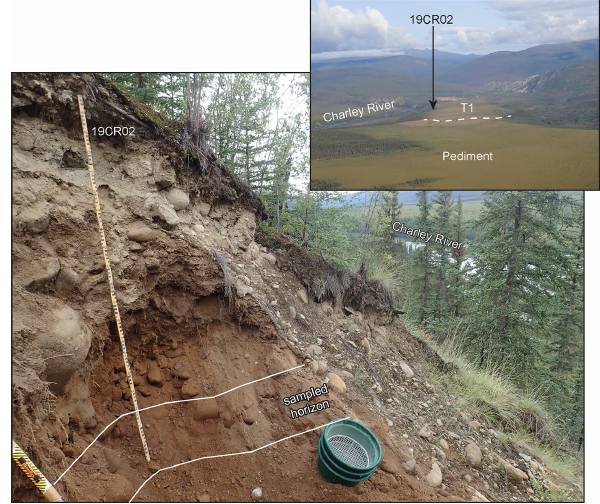
Figure A1. Cosmogenic isochron burial age sample site 19CR2. Site located on the Charley River high terrace (T1) in Alaska near the headwaters. Main photo is taken looking upstream (south), in- set aerial overview is taken looking downstream (north–northwest). Photographs by the US Geological